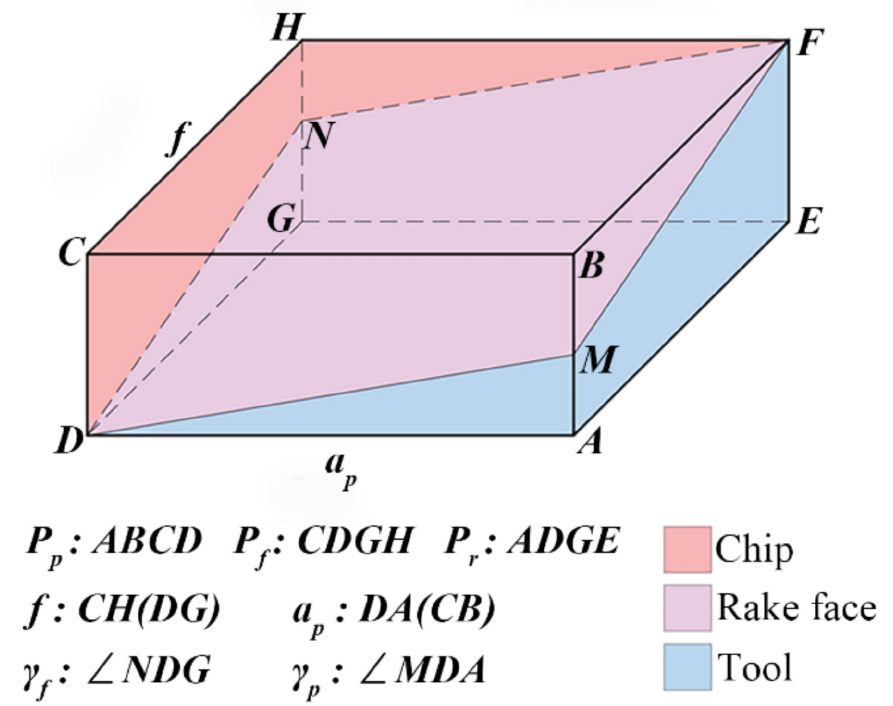
Figure 12. The diagram of the simplified tool-chip